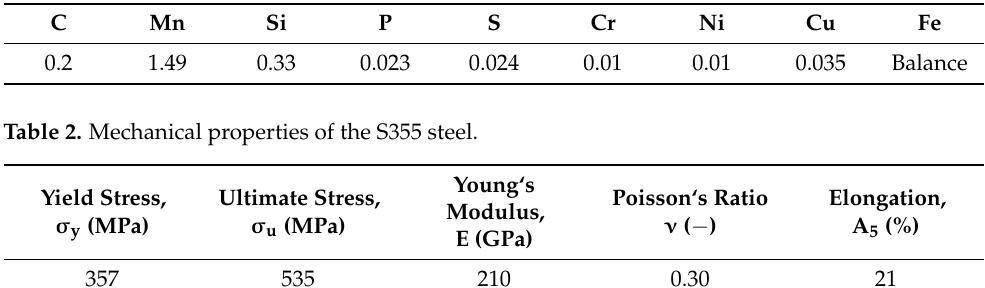
Table 1. Chemical composition of the S355 steel (in wt %).